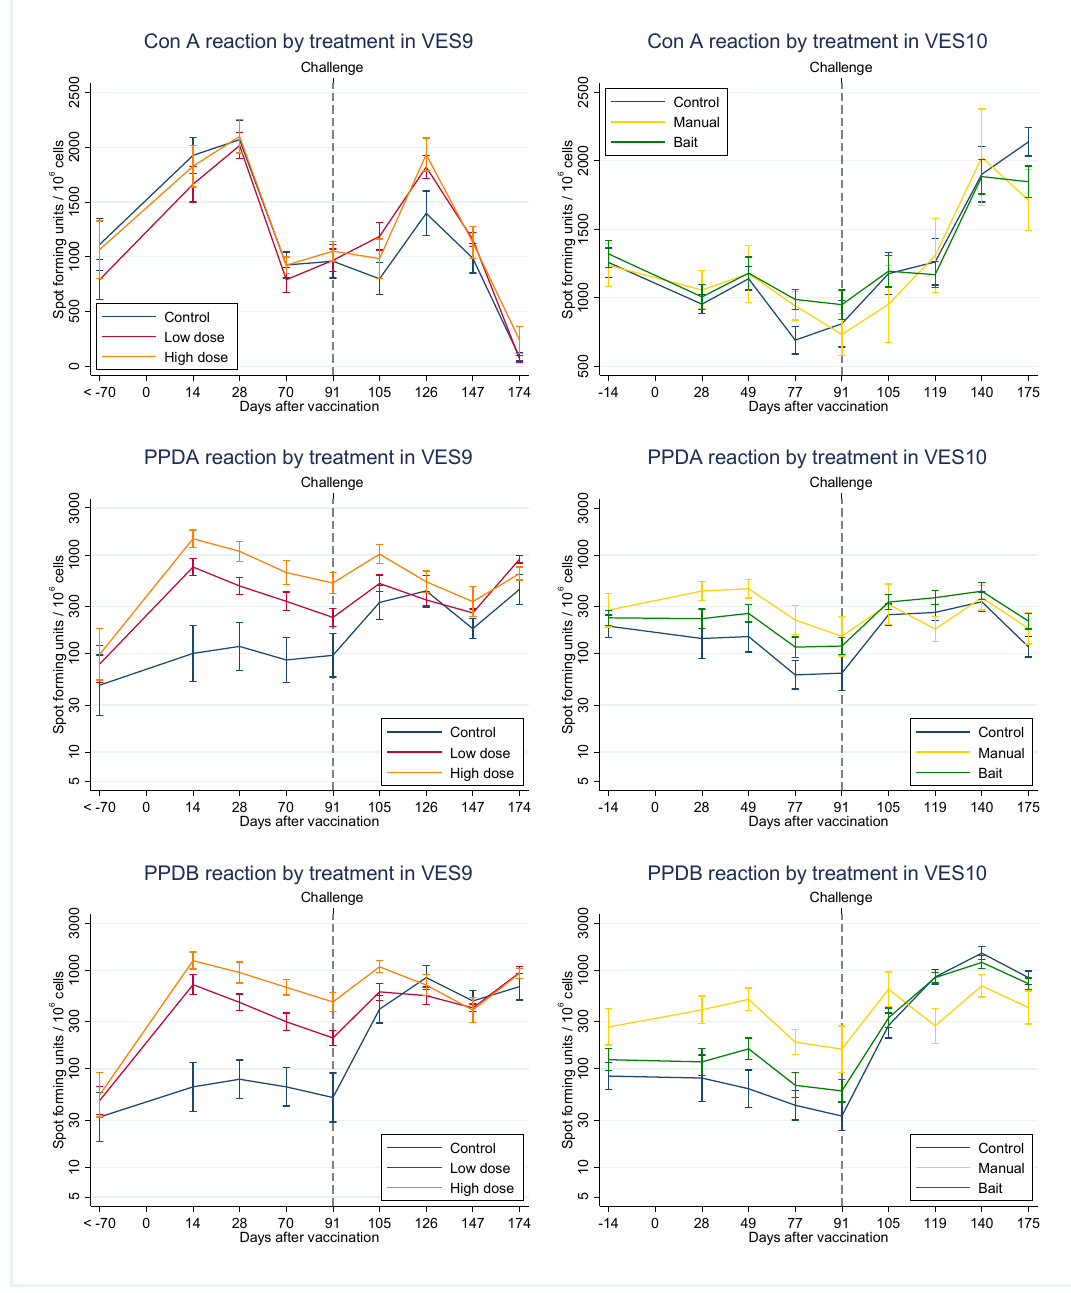
Figure 3. Interferon-gamma (IFN γ ) direct enzyme-linked immune absorbent spot (ELISpot) assay results for VES9 left and VES10 right, for each of the stimulations shown (ConA = concanavalin A. Error bars are standard errors of the means.